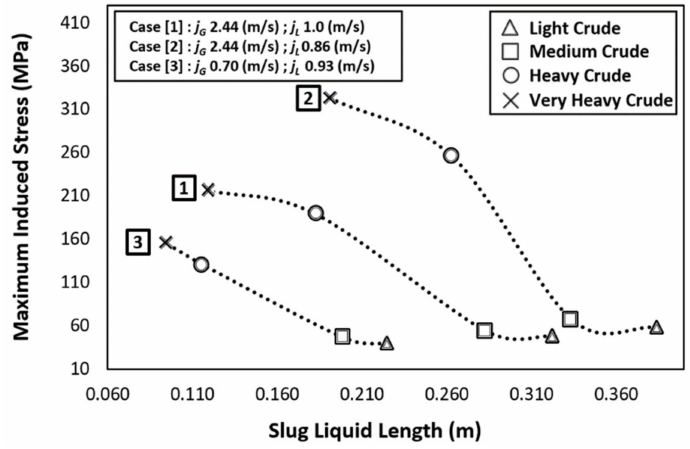
Figure 17. Effect of slug liquid length on maximum induced